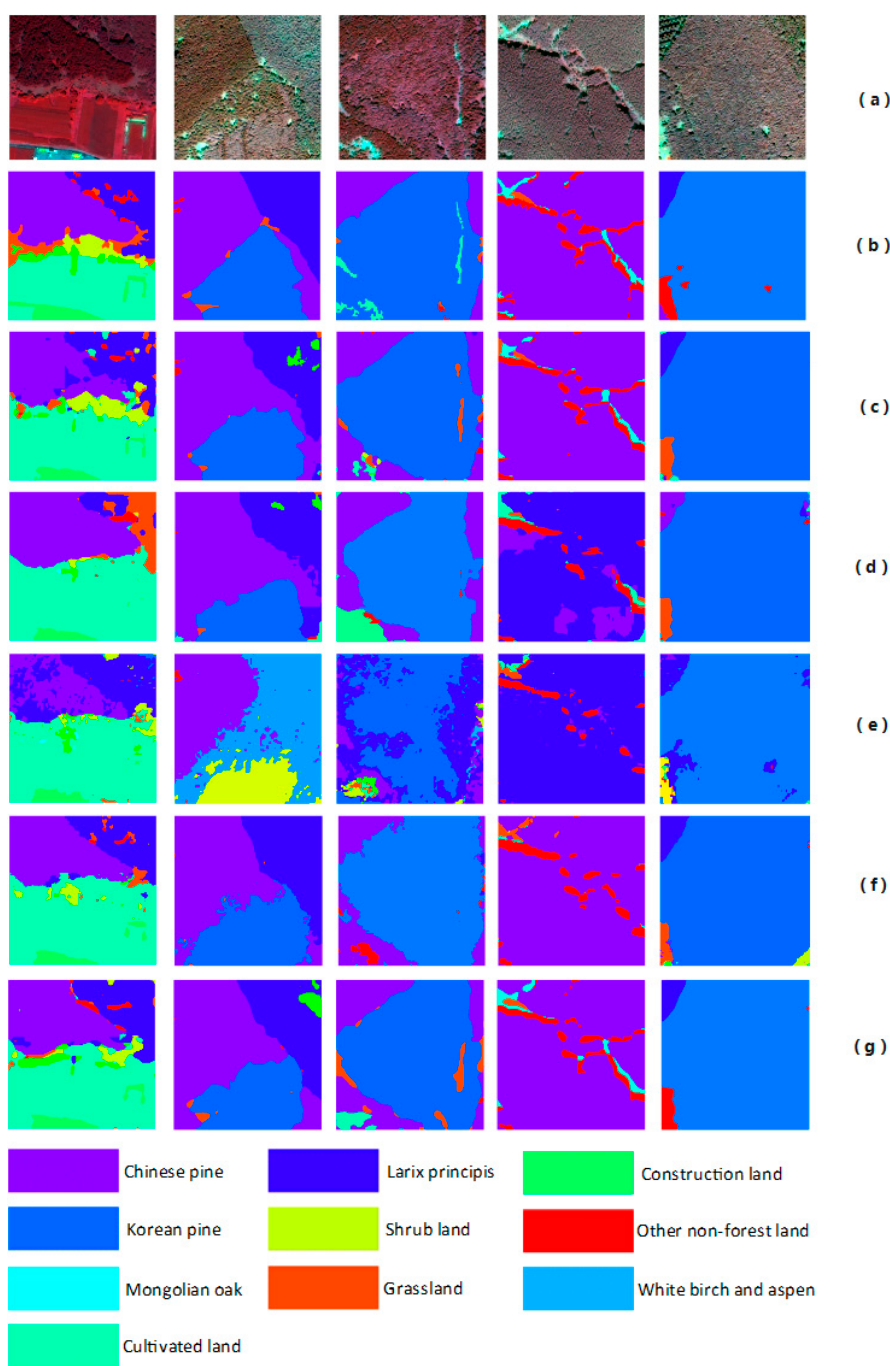
Figure 7. The detailed classification results of the Wangyedian forest farm. ( a ) GF-2; ( b ) label; ( c ) dual-uNet-Resnet; ( d ) dual-FCN8s; ( e ) UNet-Resnet; ( f ) UNet; ( g ) FCN8s.